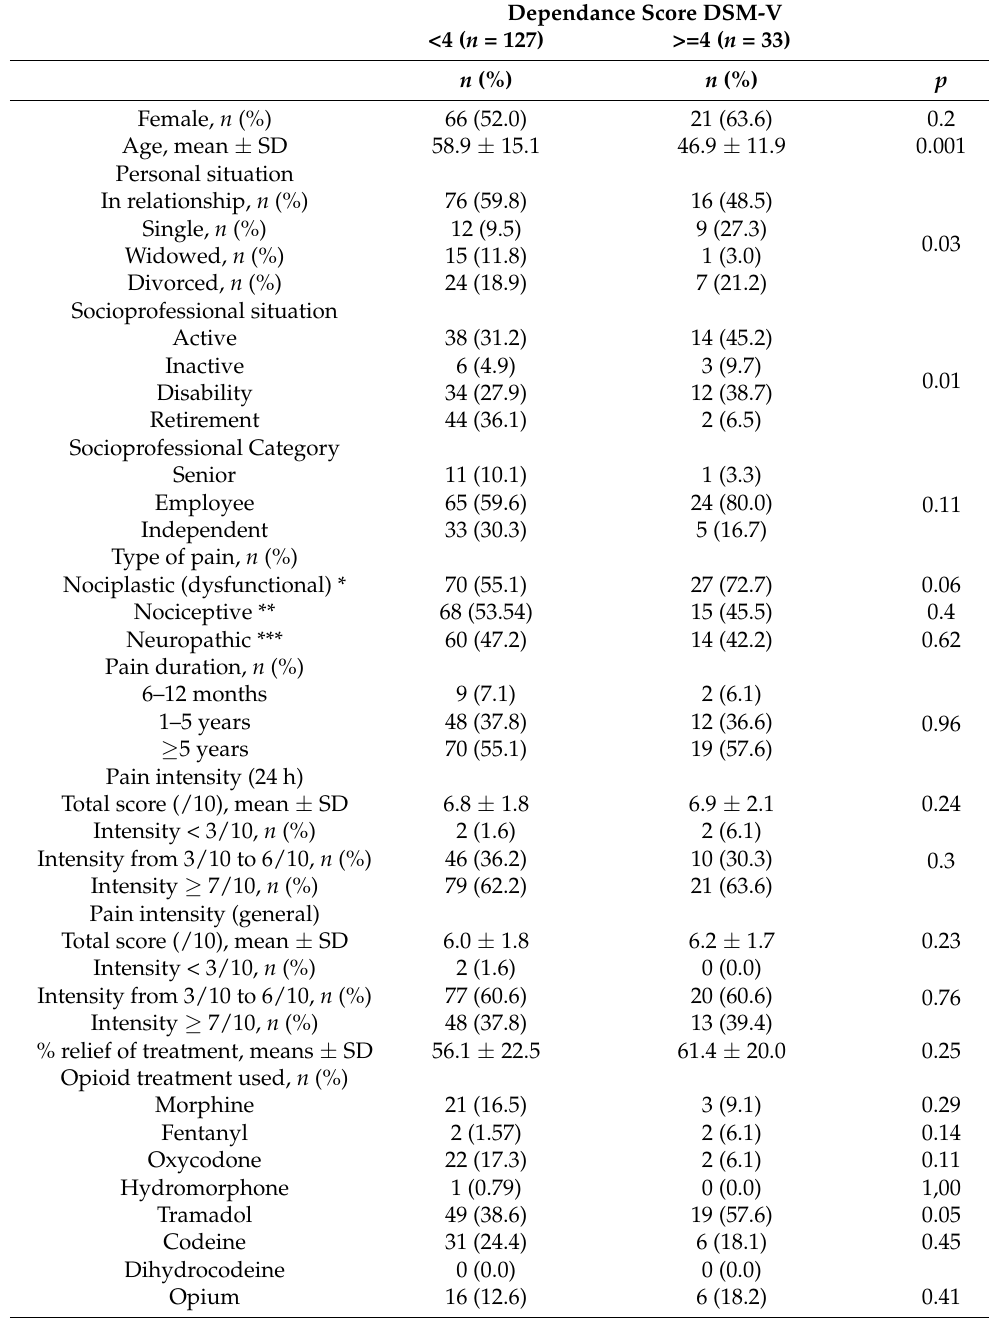
Table 2. Comparison of misusing and non-misusing patients according to their dependence score measured with the